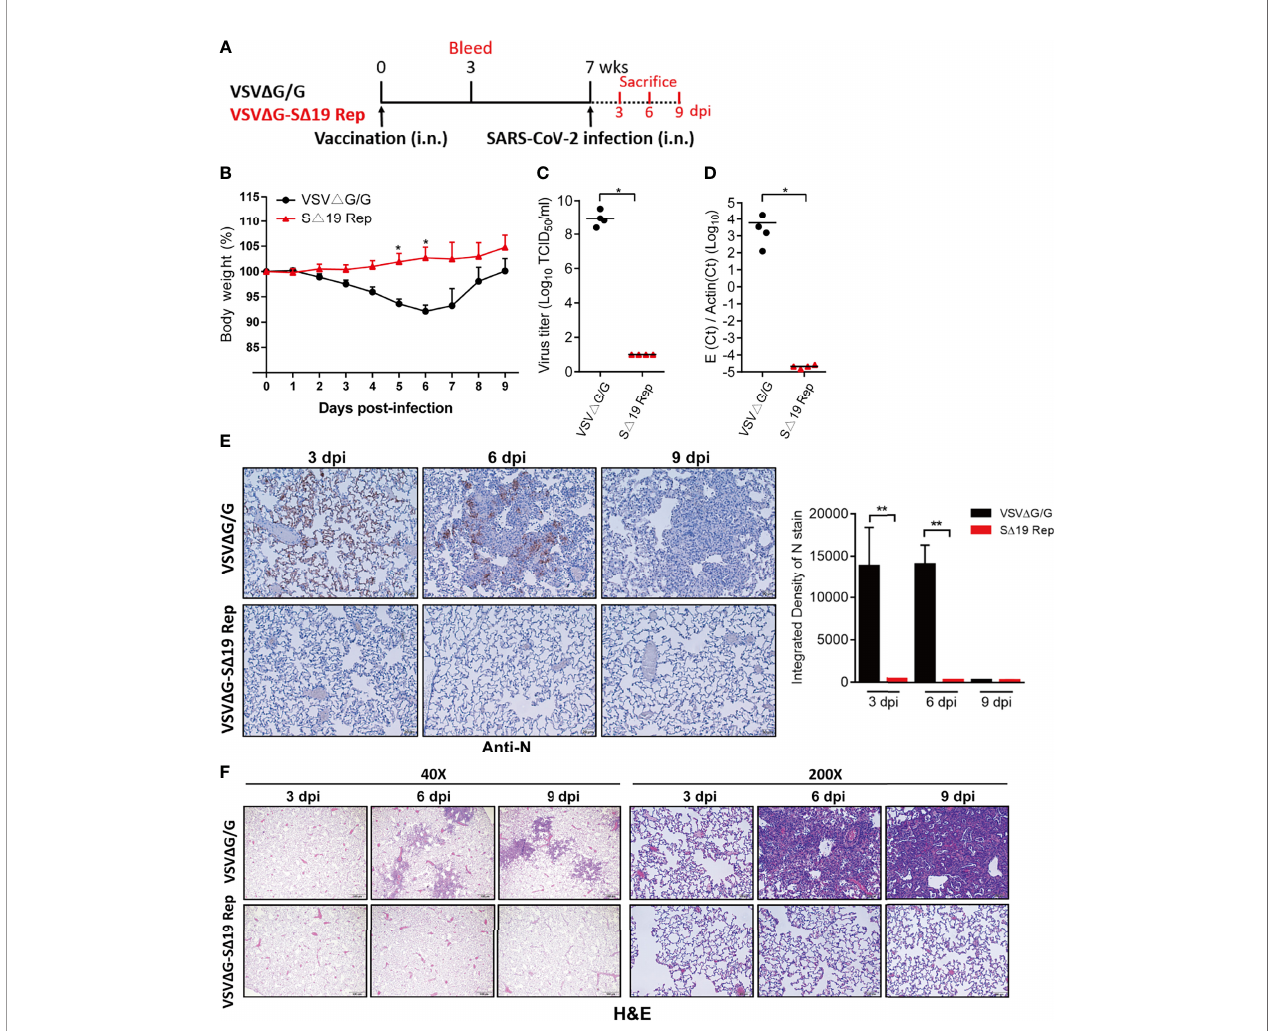
FIGURE 4 | A single dose S D 19 Rep vaccination induces effective immunity against SARS-CoV-2 infection. (A) Experimental design of a single dose vaccination (1×10 6 pfu or ffu/hamster; i.n.; n=10) and SARS-CoV-2 challenge (1×10 5 TCID 50 /hamster; i.n.). (B) Body weight loss post-SARS-CoV-2 challenge. SARS-CoV-2 virus titer (C) , viral RNA (D) , and N protein expression (E) in the lung at 3 dpi were assessed. Scale bar: 20 m m. (F) H&E staining of lung tissue (3, 6, and 9 dpi). Scale bar: 500 m m (40X) and 100 m m (200X). *P < 0.05; **P <